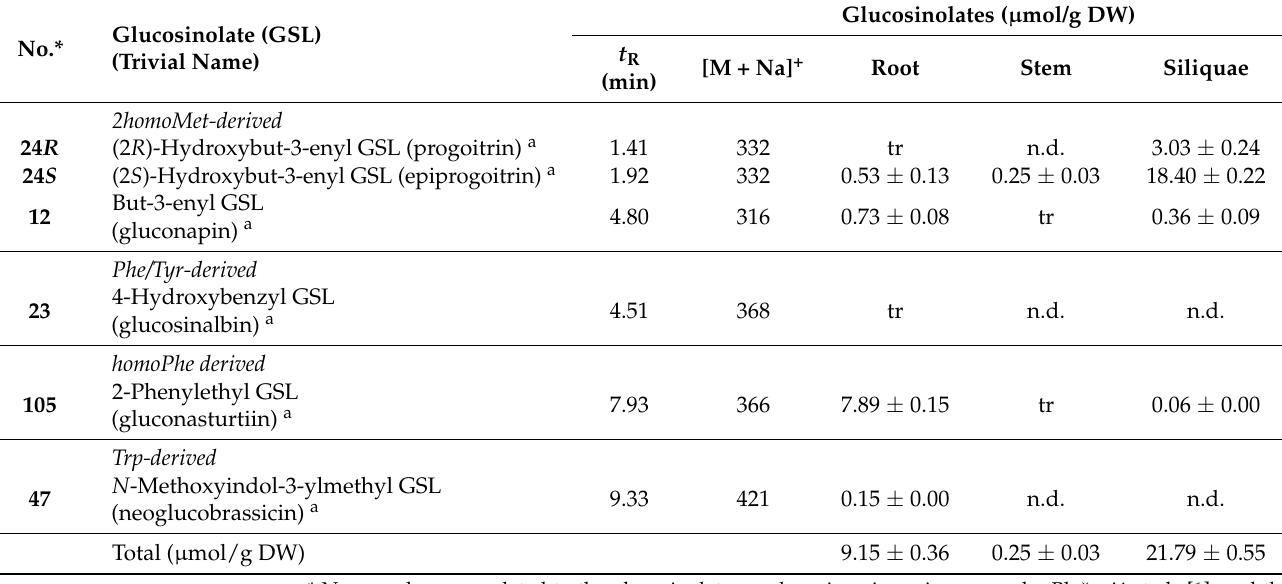
Table 3. Glucosinolate (GSL) content in Sisymbrium orientale from diverse plant